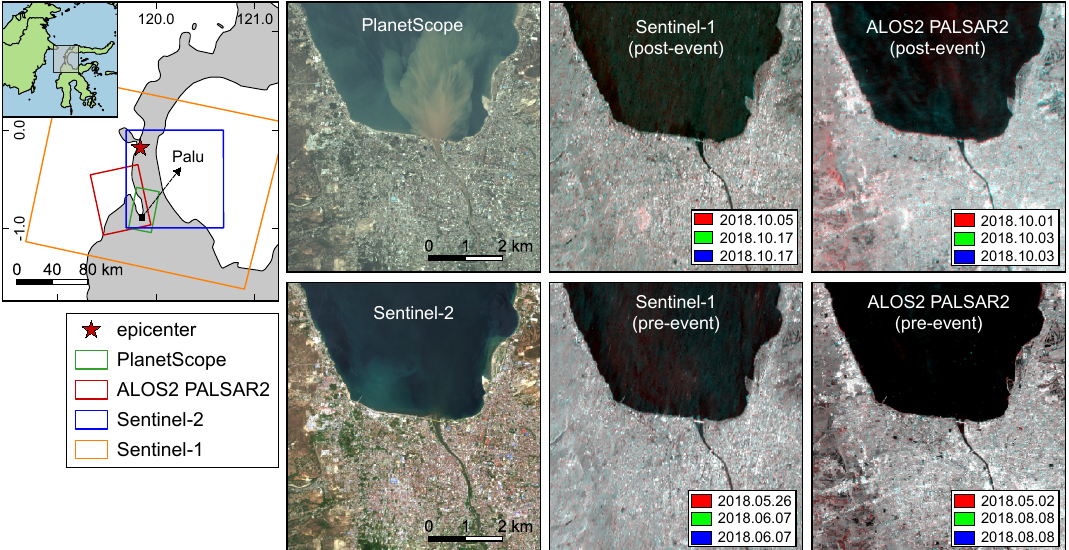
Figure 1. Data used in this study. Top left panel shows the location of the coverage of each remote-sensing image and the epicenter. Second vertical panels show the post-event PlanetScope image (top) and the pre-event Sentinel-2 image (bottom). The third and fourth vertical panels show the RGB color-composited SAR data (top: post-event and bottom: pre-event) from the Sentinel-1 and ALOS-2 PALSAR-2 sensors,